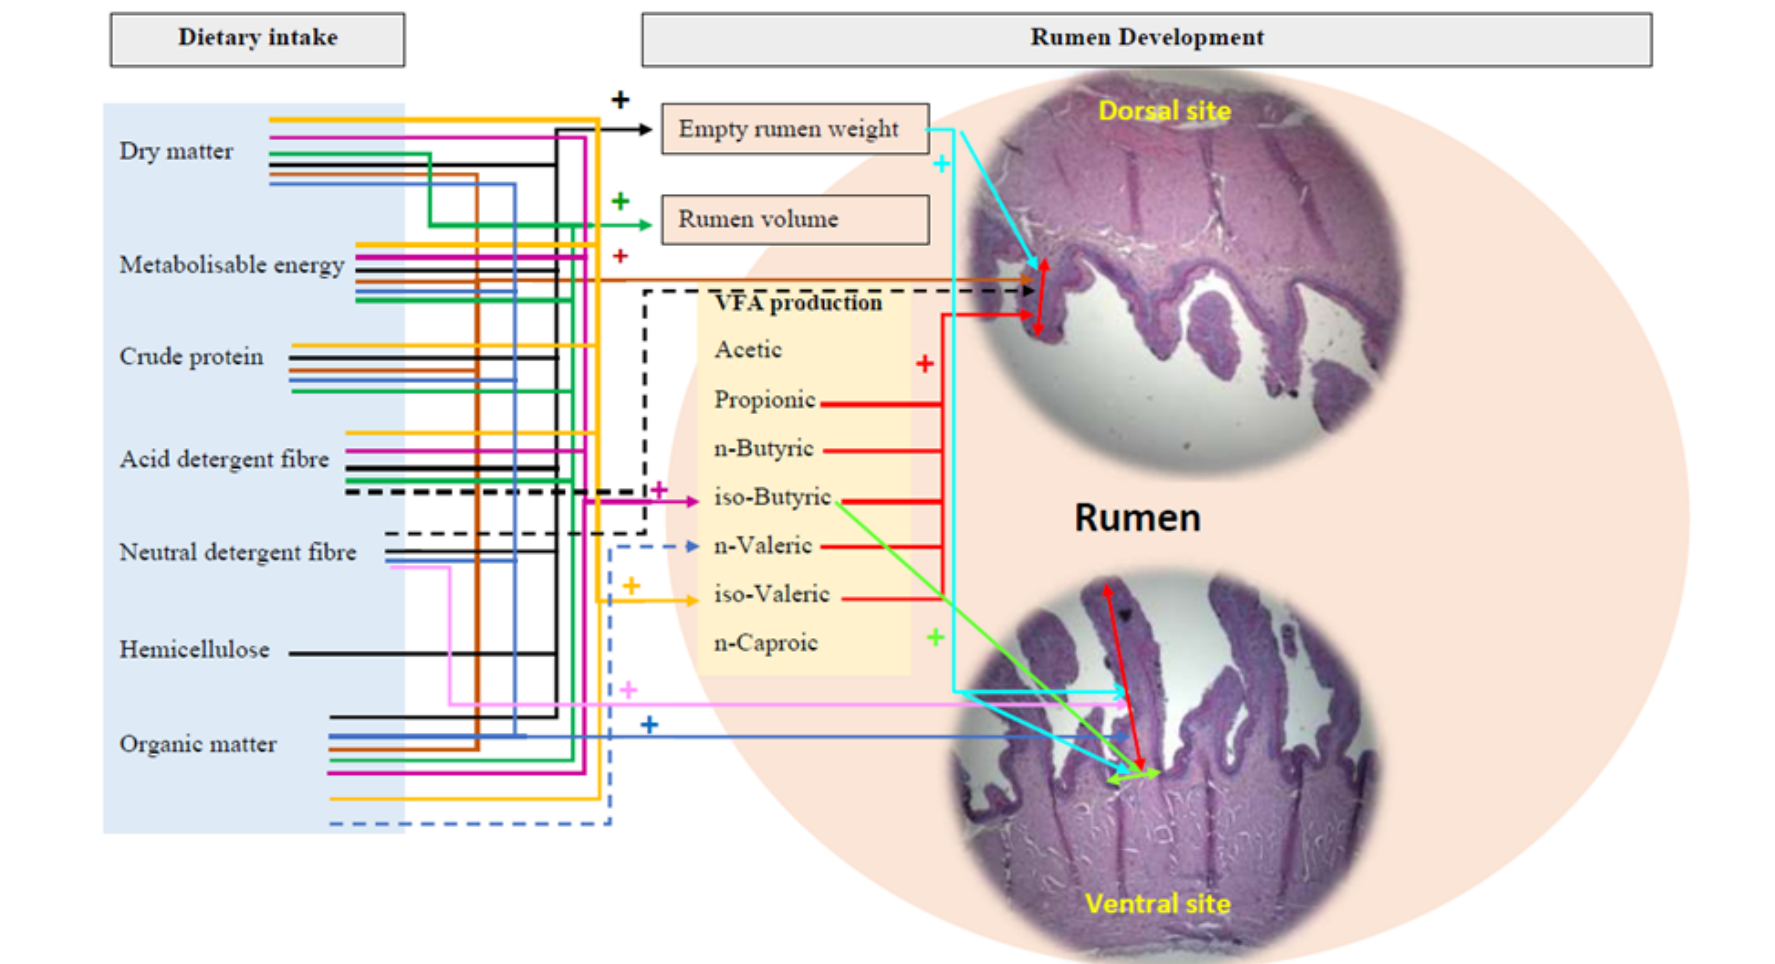
Figure 4. Schematic diagram of correlations between dietary factors and rumen development parameters of artificially reared lambs given three rearing treatments (significant ( p < 0.05) positive influence and tended positive influence). The parameters combined into a same-colour line influence the respective rumen development parameter (e.g., all parameters joined to the black-coloured solid line positively influenced the empty rumen weight).